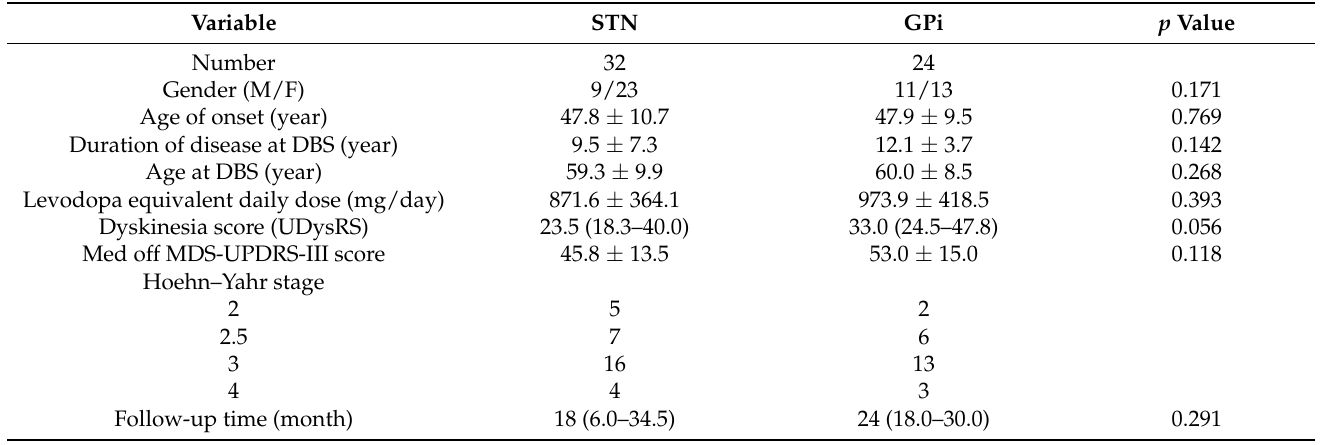
Table 1. The information in clinic and baseline demographics of all